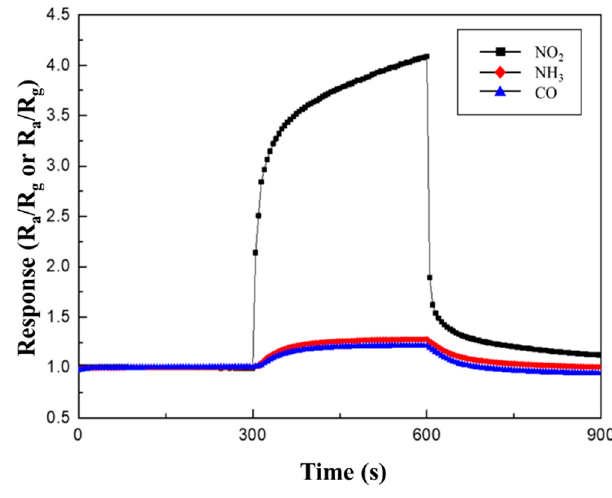
Figure 10. Response curves of 0.05 M CuO/ZnO to 100 ppm NO 2 , NH 3 , and CO gases at 250 °C.